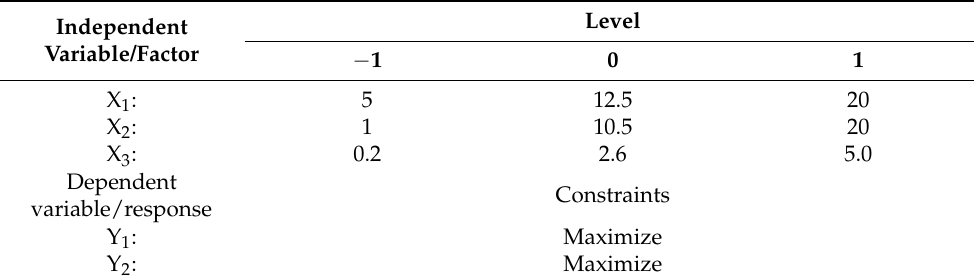
Table 2. Variables employed in